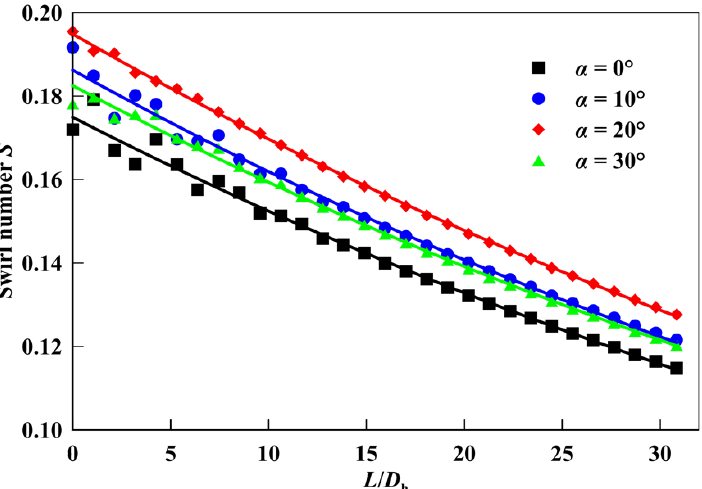
Figure 10. Decay law of swirl intensity of spiral flow induced by the hole cleaning device along the flow direction under different helix angles (numerical results).